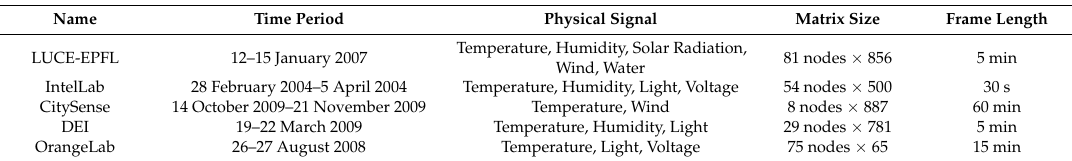
Table 1. Details of datasets in